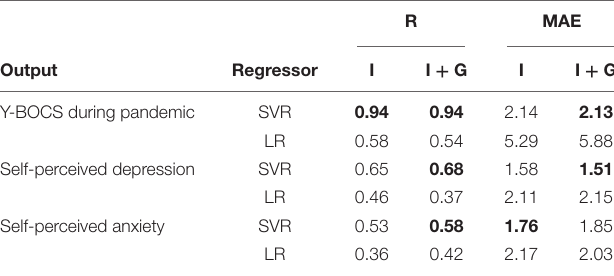
TABLE 3 | Correlation R and MAE using the SVR and LR regressors with and without gender (columns I and I + G,